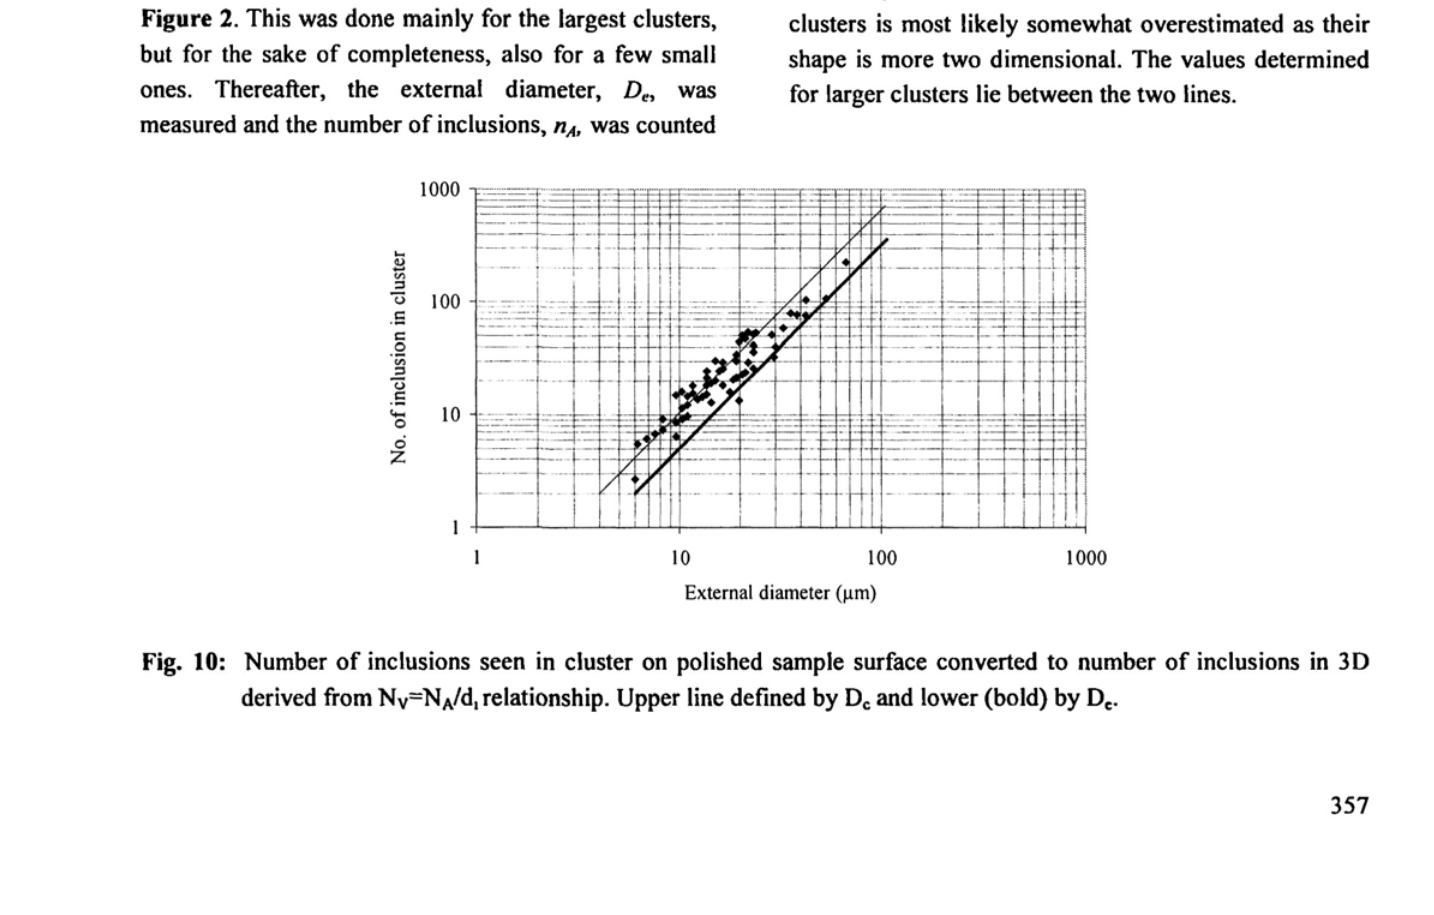
Fig. 10: Number of inclusions seen in cluster on polished sample surface converted to number of inclusions in 3D derived from Nv=N /d, relationship. Upper line defined by D A